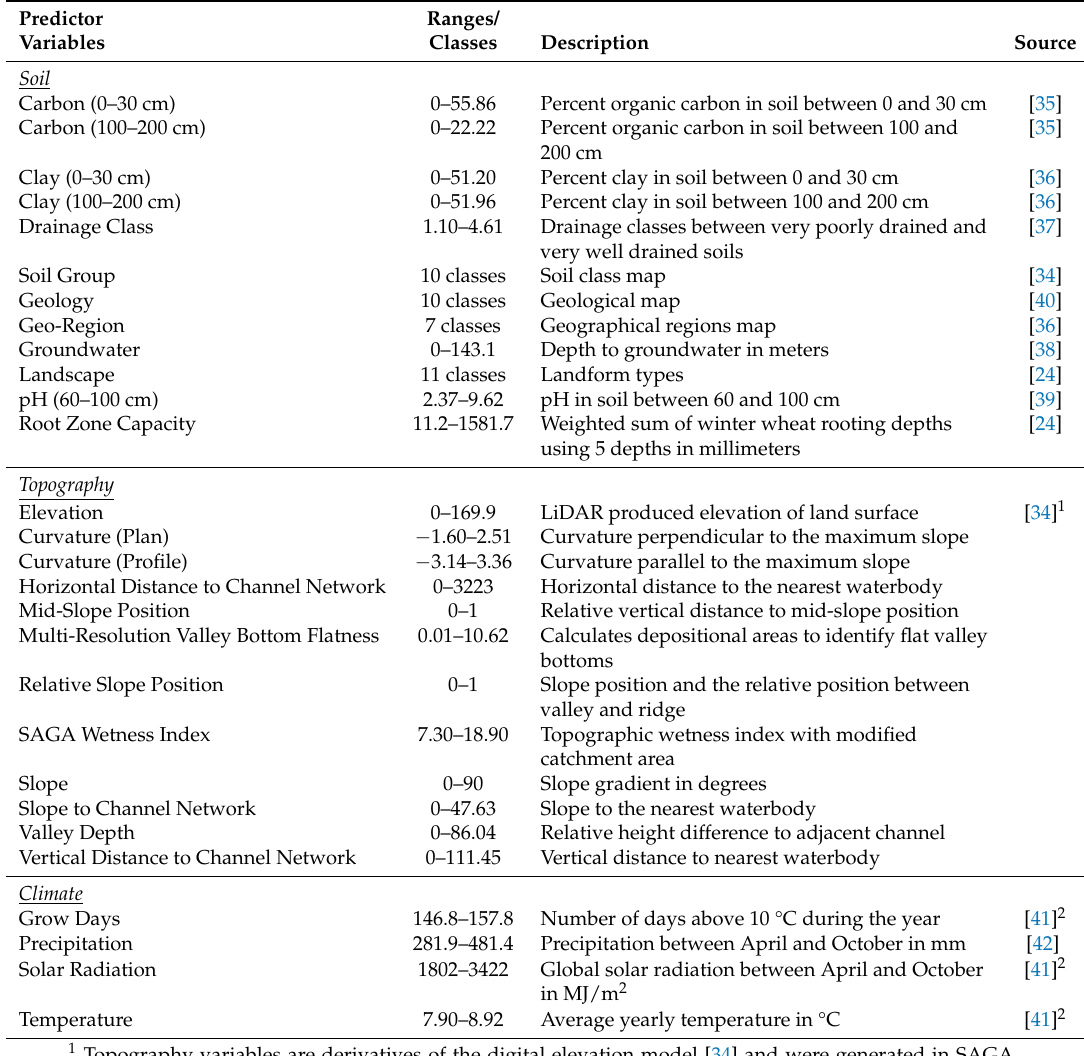
Table 1. Predictors used for random forest model of winter wheat